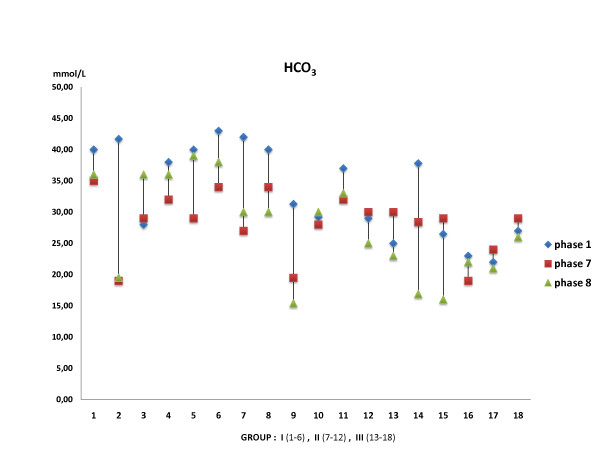
HCO3 levels. HCO3 levels graphics shows a decrease in Group III.